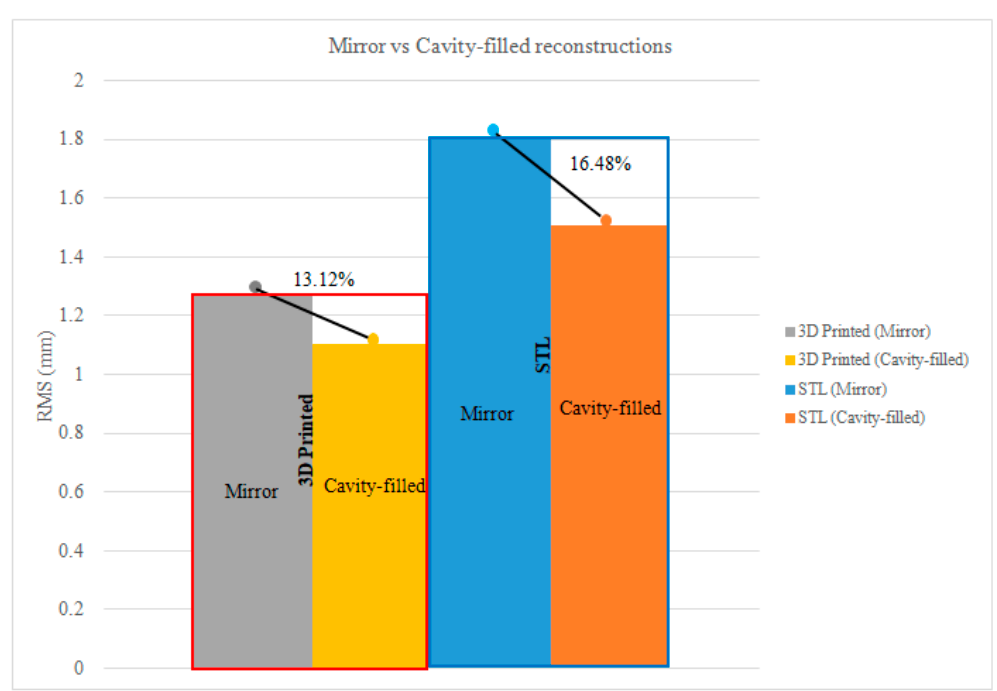
Figure 15. Graphical depiction of error reduction with cavity-filled approach.